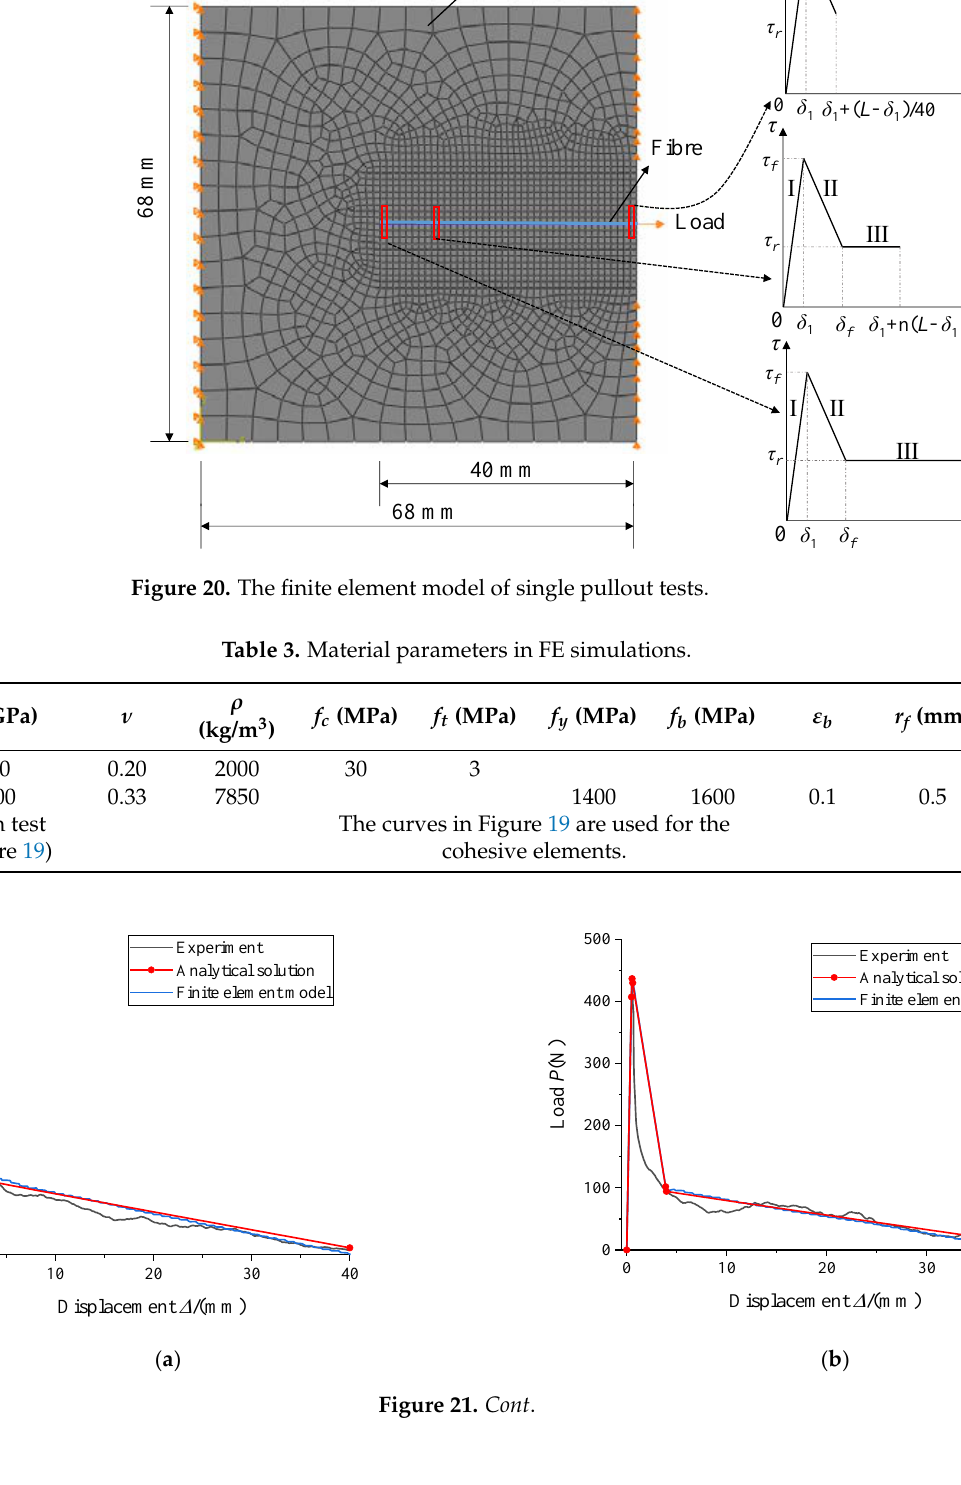
Table 3. Material parameters in FE simulations.